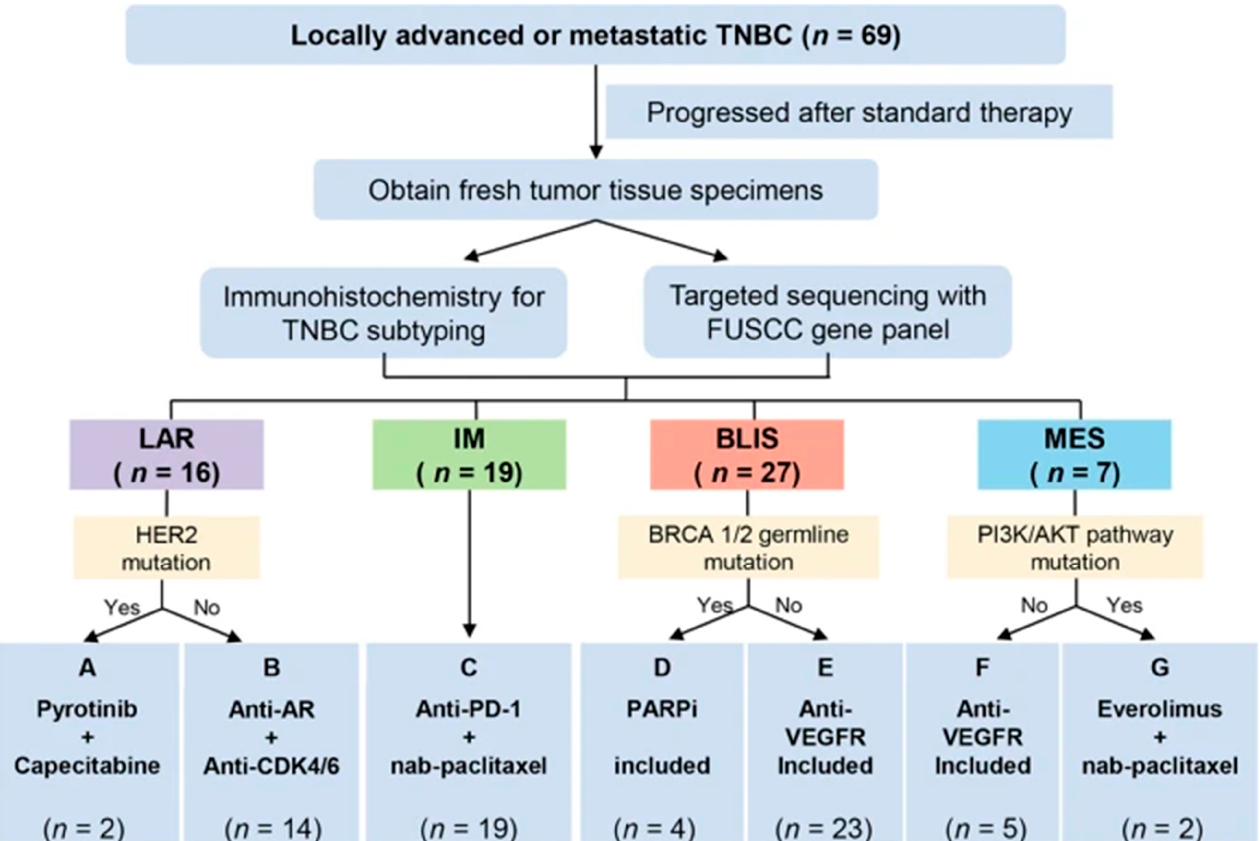
Figure 3. The FUTURE trial schema: integrating TNBC subtyping and genomic targeting. n, number of the patients; TNBC, triple-negative breast cancer; FUSCC, Fudan University Shanghai Cancer Center; LAR, luminal androgen receptor; IM, immunomodulatory; BLIS, basal-like immune-suppressed; MES, mesenchymal-like; AR, androgen receptor; PD-1, programmed cell death-1; PARPi, poly ADP-ribose polymerase inhibitor; VEGFR, vascular endothelial growth factor receptor (adapted from [136]).